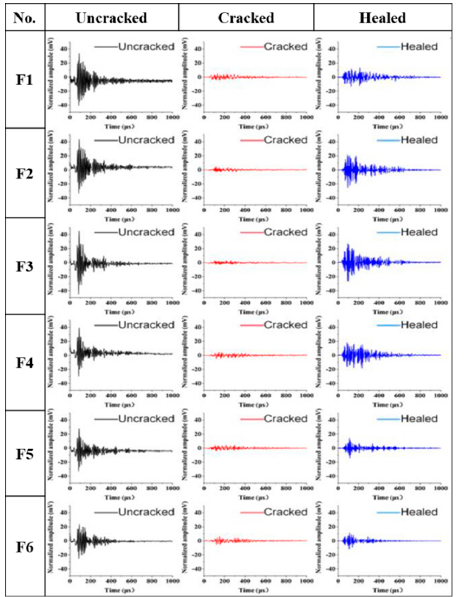
Figure 6. Ultrasonic waveform analysis of samples. (F1–F6 are the group numbers of cement particles with the average size 22.82 μ m, 29.78 μ m, 39.10 μ m 49.96 μ m, 60.51 μ m and 73.60 μ m, respectively.).